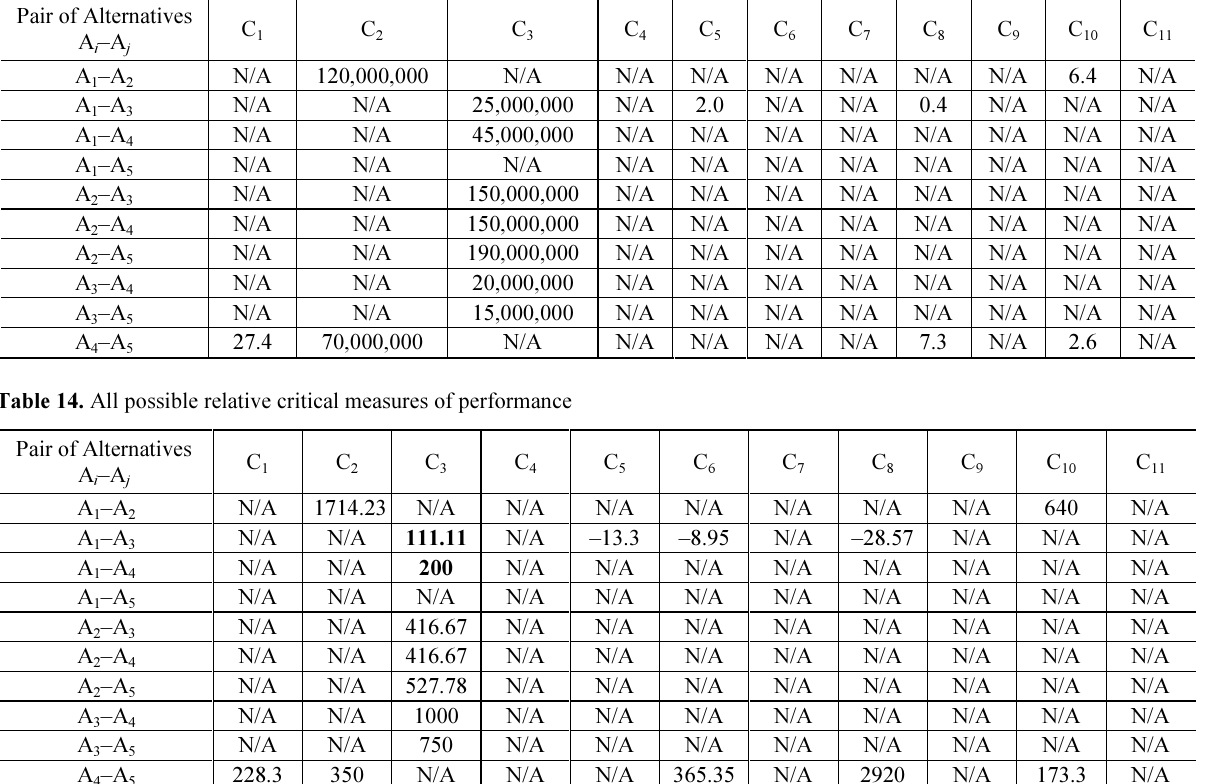
Table 13. All possible absolute critical measures of performance Pair of Alternatives